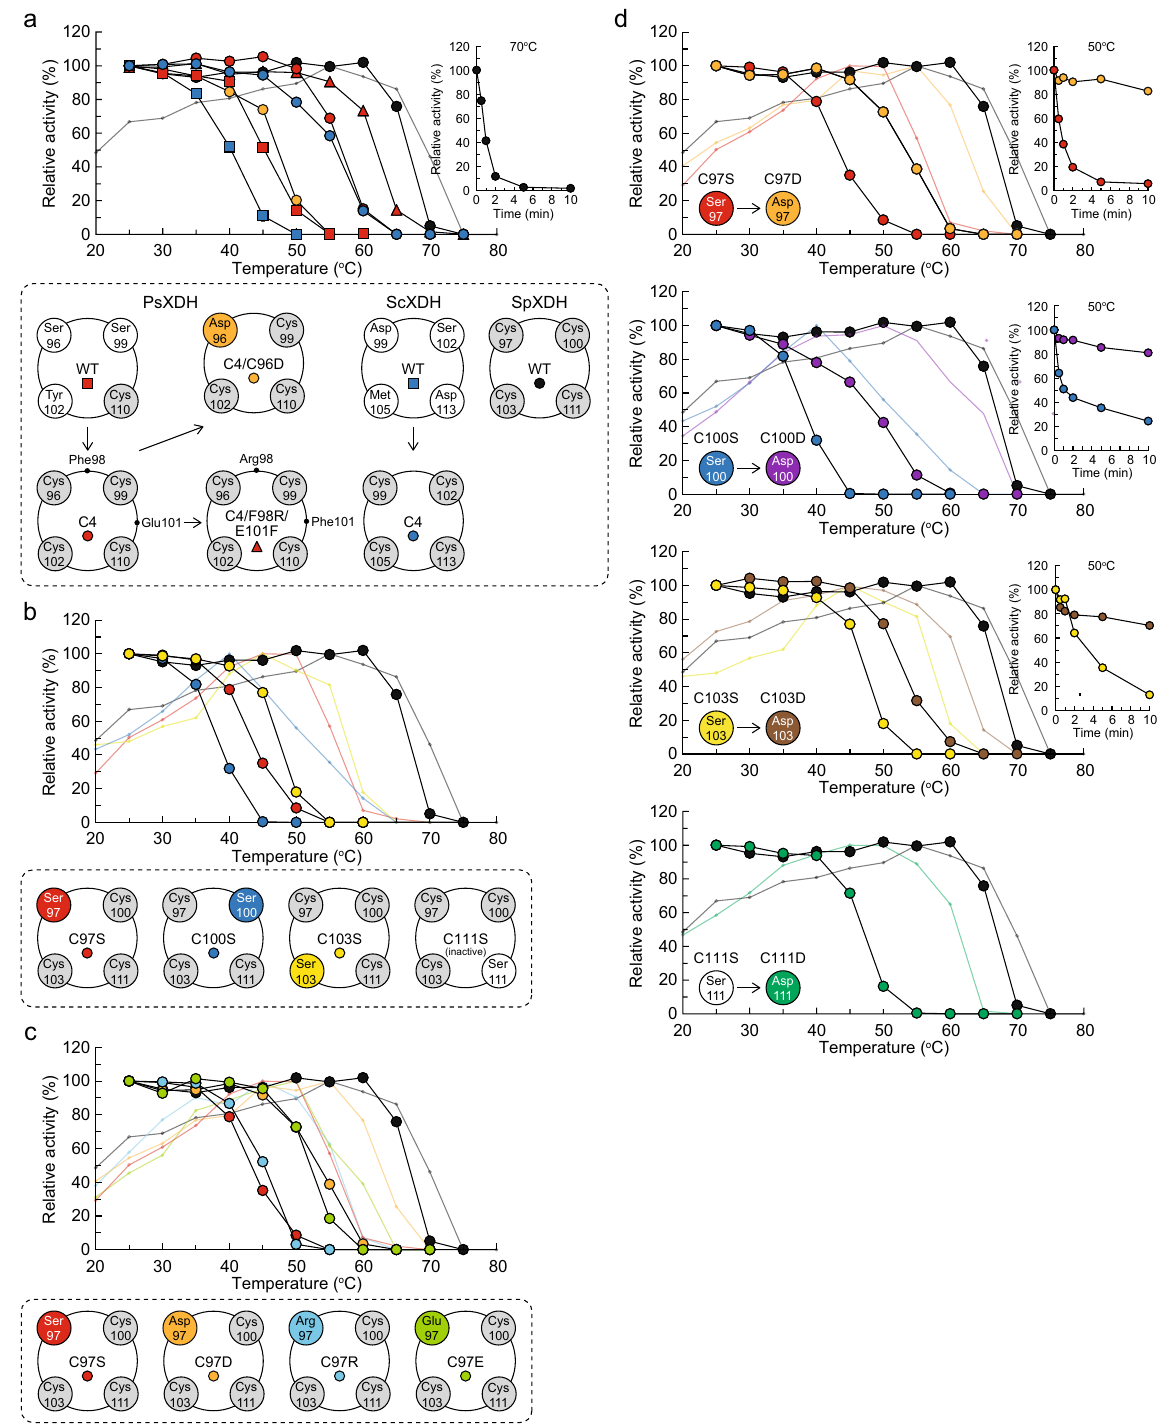
Figure 6. Courses of thermal inactivation. Purified enzymes were dialyzed against 50 mM Tris–HCl (pH 8.0) at 4 °C overnight. Dialyzed enzymes were incubated for 10 min at each temperature or at the indicated temperature for each time (inset). Enzyme activities were shown as relative average values ( n = 3) expressed as a percent of the controls without a heat treatment. The background graph shows the effects of temperature on activity. ( a ) WT and mutants of PsXDH and ScXDH and WT of SpXDH. ( b ) Four serine mutants of SpXDH. ( c ) Four Cys97 mutants. ( d ) Four aspartate mutants and comparisons with each serine